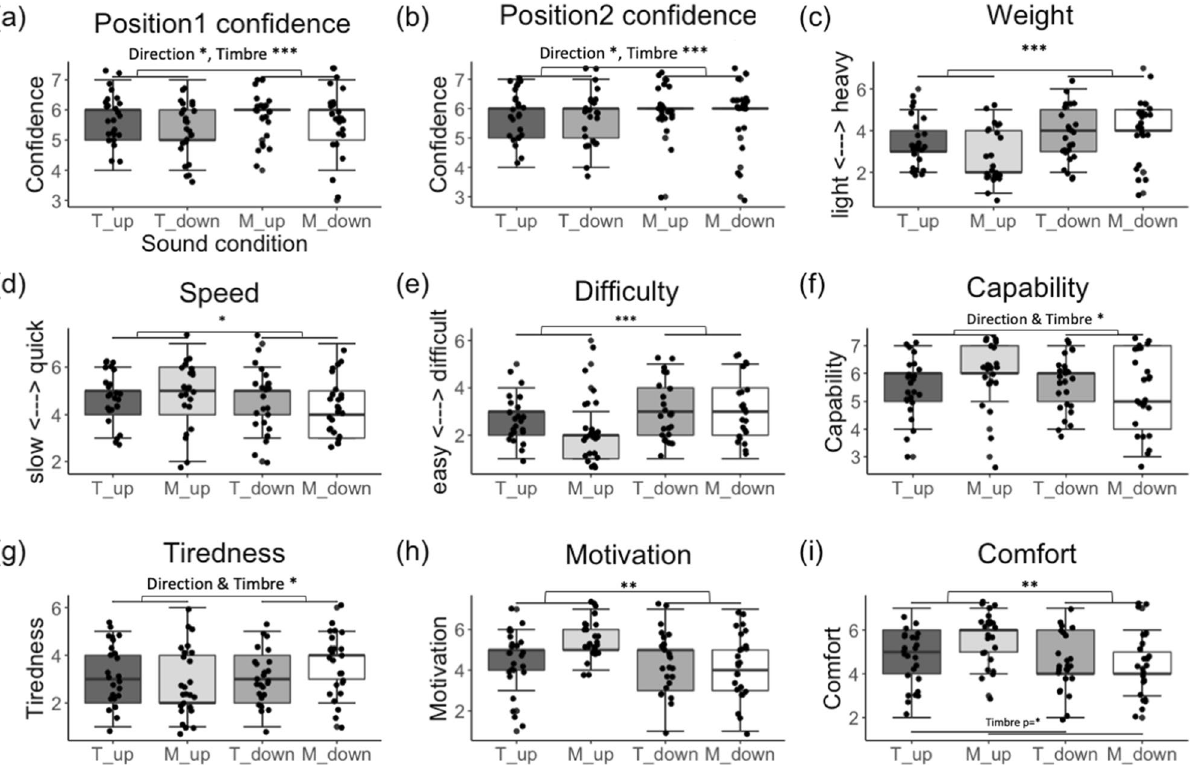
Figure 3. Boxplot with median (range) score for the feelings of confidence in having reached the requested position, feelings about one’s body and the bodily movement for all sound conditions in Experiment 2. ( a ) Feelings of position confidence in Position 1 and ( b ) Position 2; ( c ) feelings of body weight and ( d ) speed; ( e ) feelings of difficulty, ( f ) capability, ( g ) tiredness, ( h ) motivation and ( i ) comfort during the exercise. T_ up = “Tone_up”, T_down = “Tone_down”, M_up = “Musical_up”, M_down = “Musical_down”. Note that in ( a ) and ( b ), related to position confidence, for the conditions Musical_up in both positions and Musical_down in Position 2 we observe a large concentration of participants’ answers around point 6 of the scale, suggesting that participants felt quite confident about their position with only few participants deviating from point 6. For the other conditions, we observe left- or right-skewed data, due to a larger dispersion in participants’ responses. The asterisks indicate significant differences between sound conditions (* indicates p < 0.05, ** indicates p < 0.01, *** indicates p < 0.001; all corrected for multiple